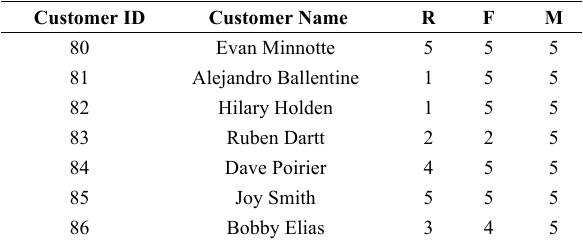
TABLE IV. ACTUAL RFM VALUES OF CUSTOMERS Customer